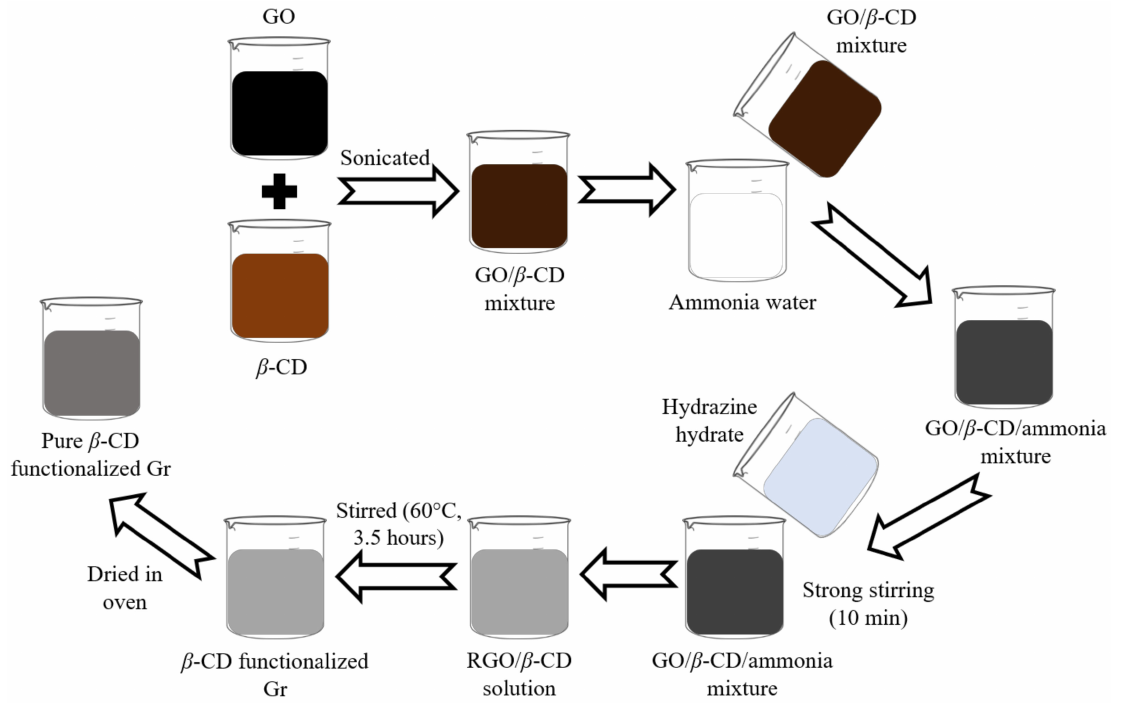
Figure 2. Schematic preparation of the pure β -CD functionalized Gr [112]. A low LOD of 0.008 µ M has been achieved when Gr was incorporated with an acetylene black paste hybridized electrode for the LSV detection of 4-NP. This might be due to the high specific surface area and strong adsorption capacity of the acetylene black [116]. Next, hydroxyapatite with good adsorption capability has been integrated with Gr for 4-NP sensing that managed to give an LOD of 0.27 µ M